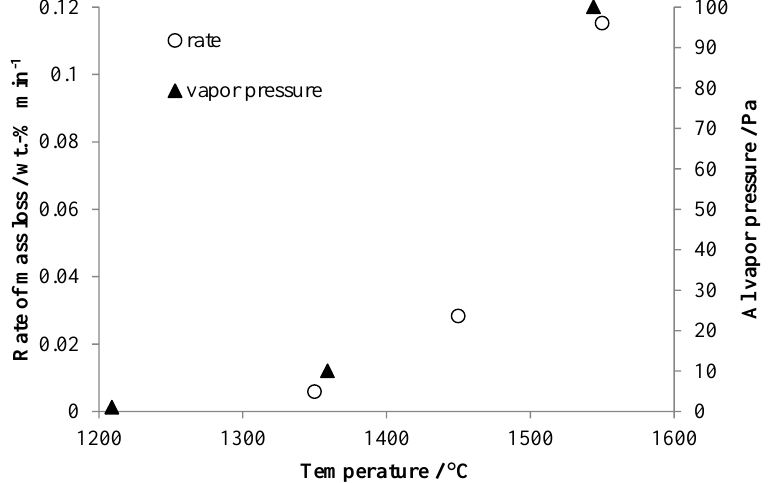
Figure 5. Rates of mass loss duringaluminum evaporation taken from Figure 4 compared to the published vapor pressure ofaluminum at similar temperatures. Thealuminum vapor pressure data was taken from http://www.knowledgedoor.com/2/elements_handbook/vapor_pressure.html (accessed on 28 April 2017).